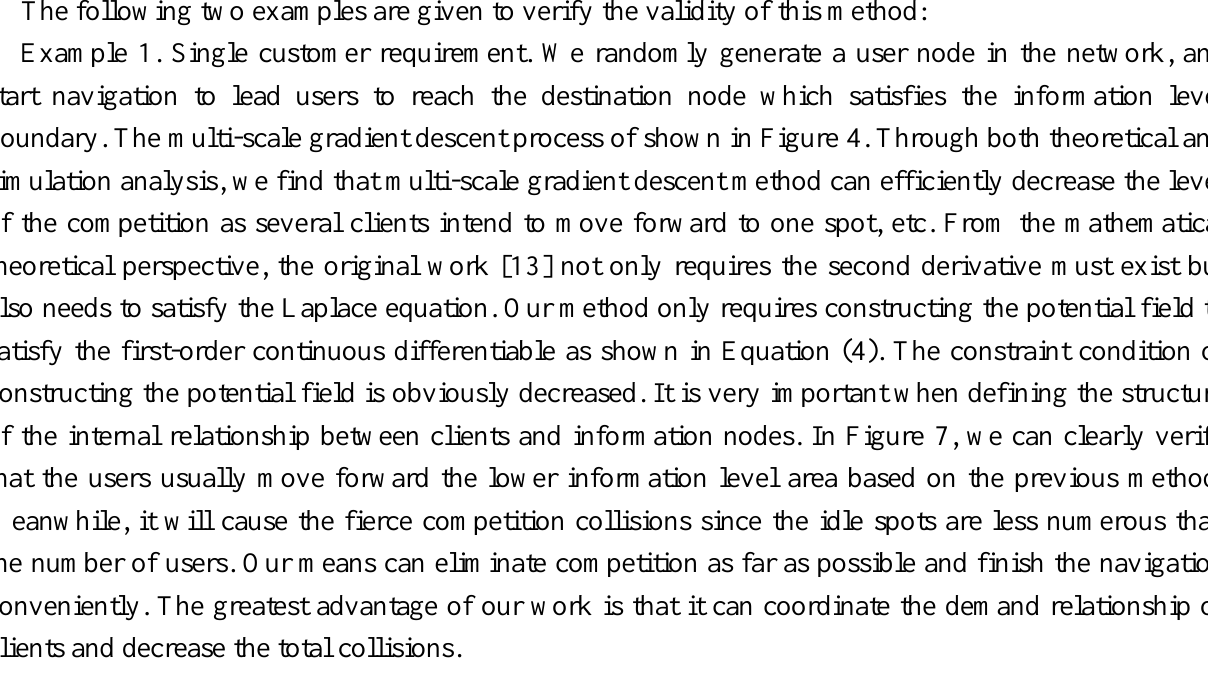
Figure 4. Multi-scale gradient descent process of single user. (a) Large scale gradient descent; (b) Small scale gradient